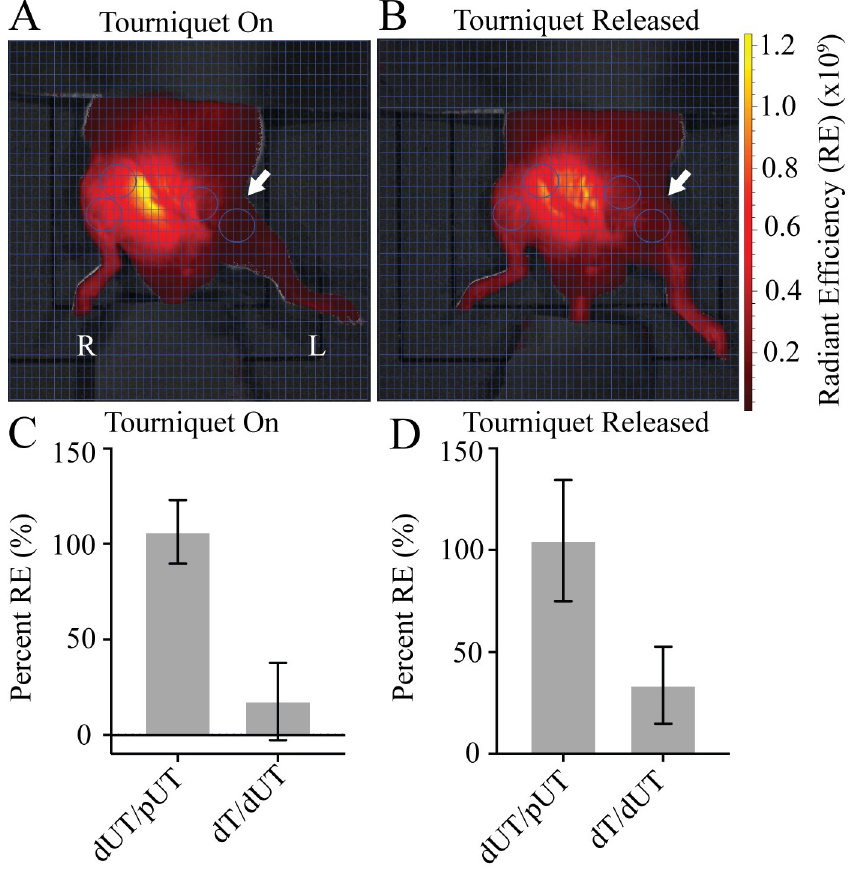
Fig 1. Mice demonstrate plasma flow distal to the tourniquet. A) Tourniquet placement (arrow) shows Angiosense (red) distal to the tourniquet in the left leg while the tourniquet is in place. B) Release of tourniquet restores flow to the distal limb. Region of interest (ROI—circles) target areas proximal and distal to the tourniquet in both tourniqueted left leg (L), and untourniqueted (R) right leg limbs. Ventral view. Fluorescent signal indicates Angiosense detection (red) in units of radiant efficiency (RE) (see scale bar). Representative images shown, N = 8. C) Plasma flow in the dUT/pUT and dT/dUT limbs with the tourniquet on. D) Plasma flow in the dUT/pUT and dT/dUT limbs after tourniquet released. N = 8. Error bars represent